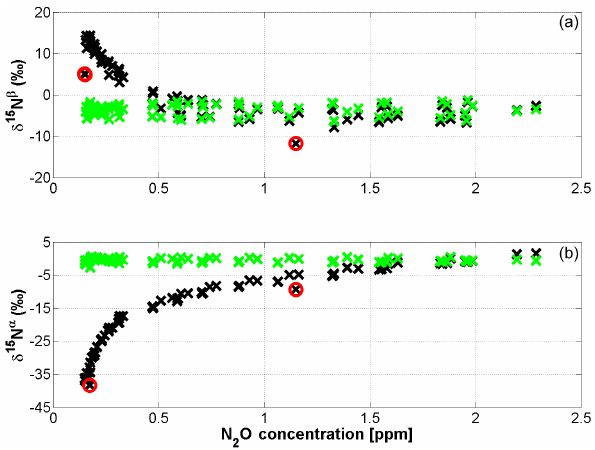
Figure 2. The concentration-dependent correction (CDC) for (a) δ 15 N α and (b) δ 15 N β . In both figures, the raw data are pre- sented in black, the CDC data are plotted in green, and the outliers are marked with red